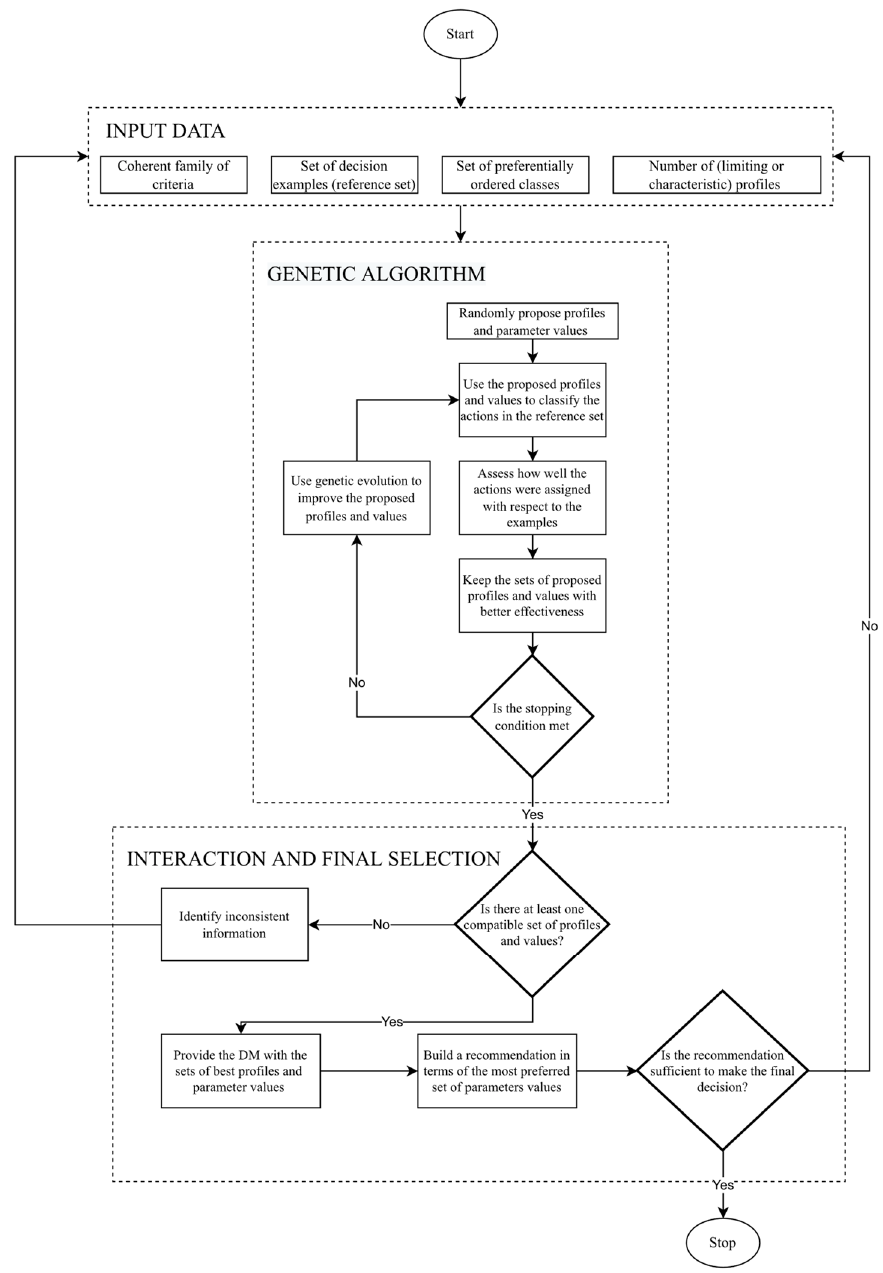
Figure 1. General scheme of the proposal.